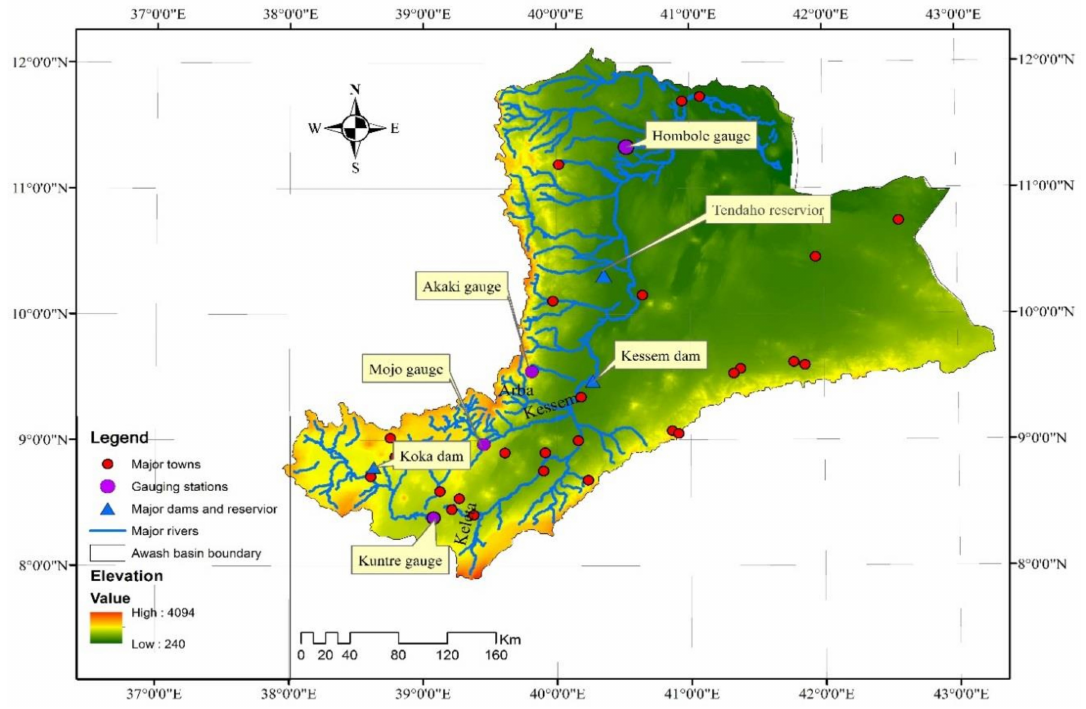
Figure 1. Location map of the Awash River